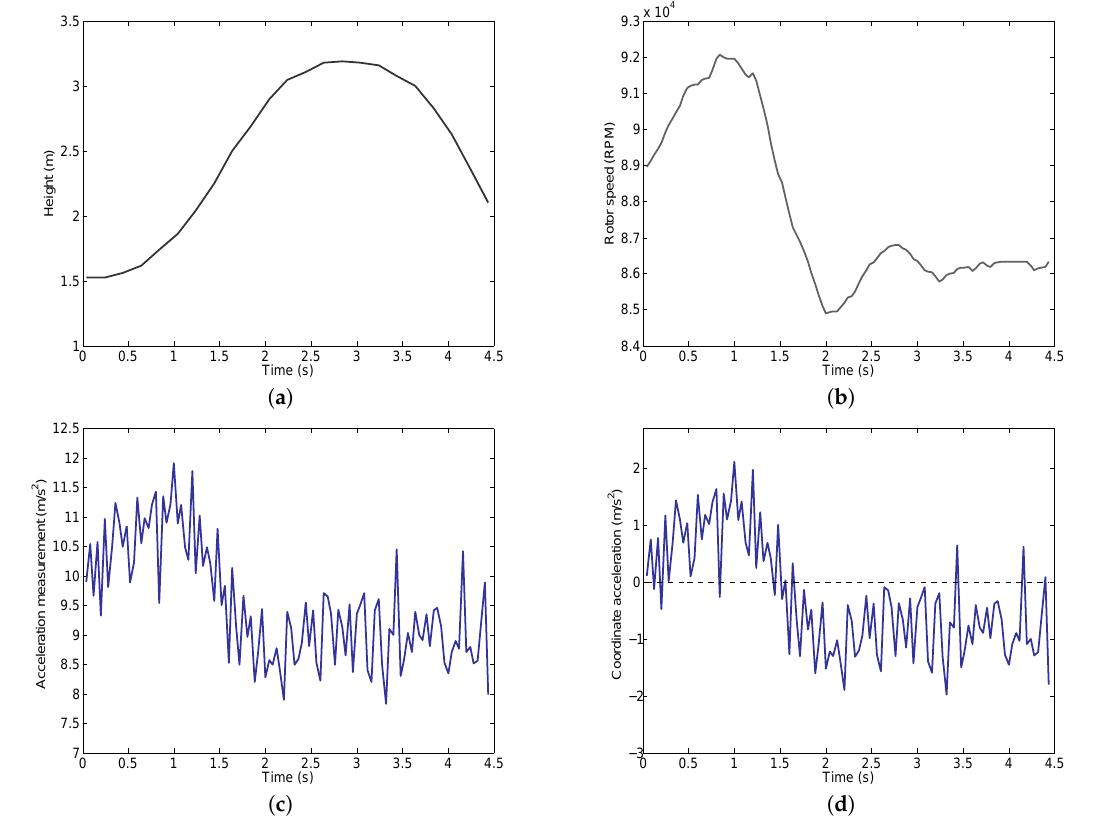
Figure 11. Experiment results. ( a ) Experiment height measurement; ( b ) Experiment rotor speed; ( c ) Experiment acceleration measurement; ( d ) Coordinate acceleration (computed from Figure